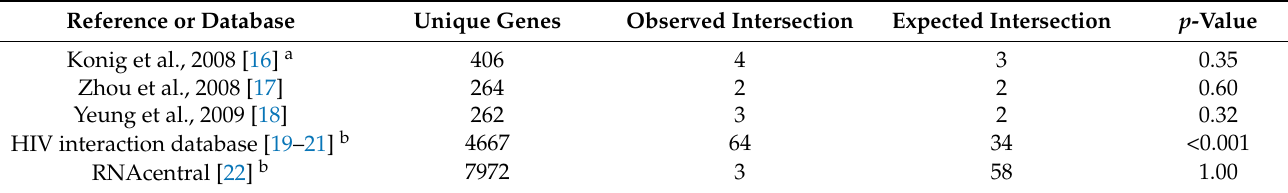
Table 2. Cross-reference of individual studies with the meta-analysis results and other studies involving HIV-1 replication and life cycle, alongside HIV Human Interaction Database and RNAcentral, a database of non-coding RNA. The binomial distribution was used to test the null hypothesis that the intersection of the original source with the meta-analysis list is equal or less than expected by chance via one-sided tests.